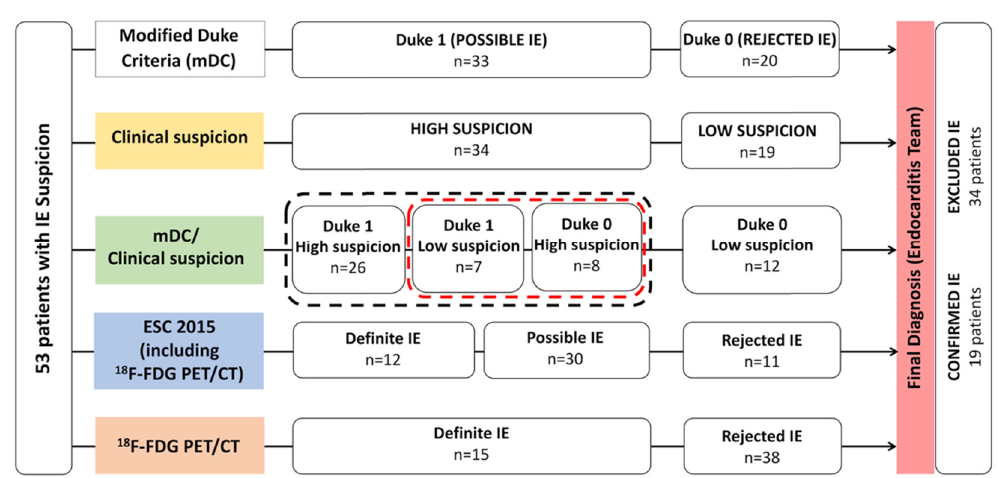
Figure 1. Main study design and patient population classifications. Black dotted line regroups patients needing cardiac imaging (Cardiac-CT, 18F-FDG PET/CT, or Cardiac-MRI) according to ESC 2015 guidelines. Red dotted line regroups the strongest classification discordances.